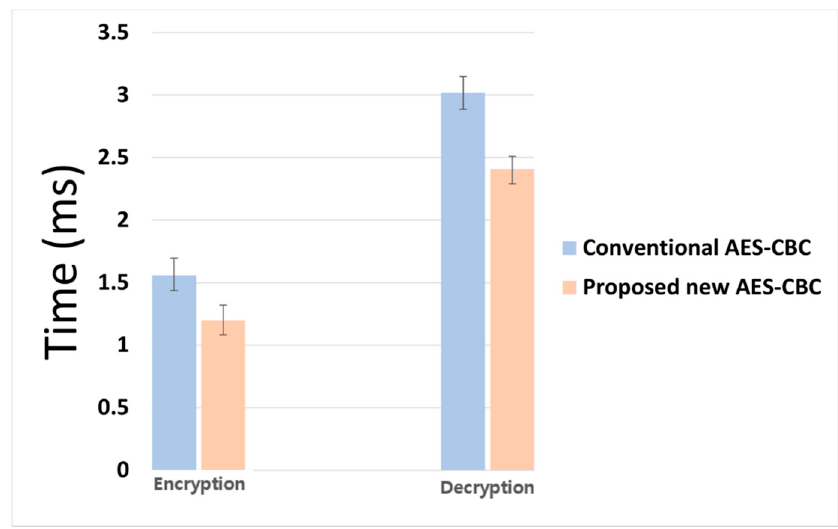
Figure 15. Average time taken during encryption and decryption in conventional AES-CBC and proposed AES-CBC algorithms. Table 6. Average time taken and its standard deviation during encryption and decryption.